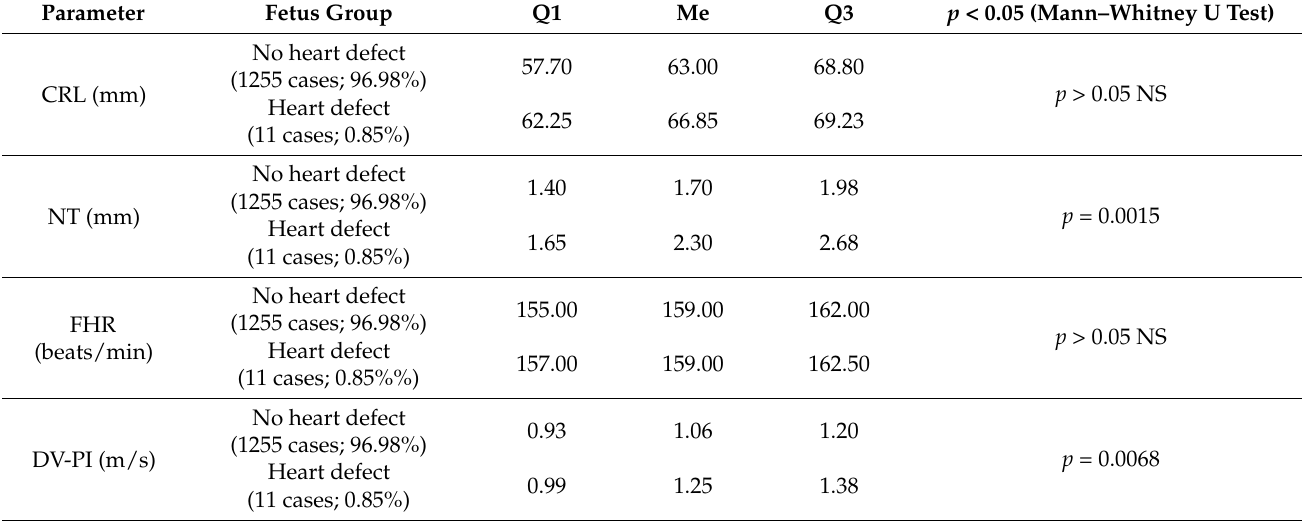
Table 1. Assessment of the parameters describing the growth and health of the fetus with or without detected heart defects, based on ultrasound examination in a group of women who became pregnant without using assisted reproduction